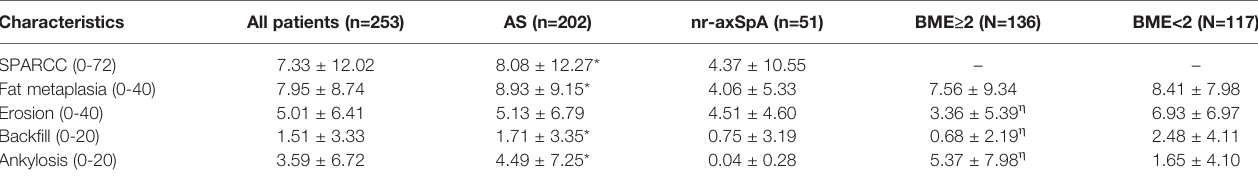
TABLE 2 | MRI in fl ammatory and structural damages. Characteristics